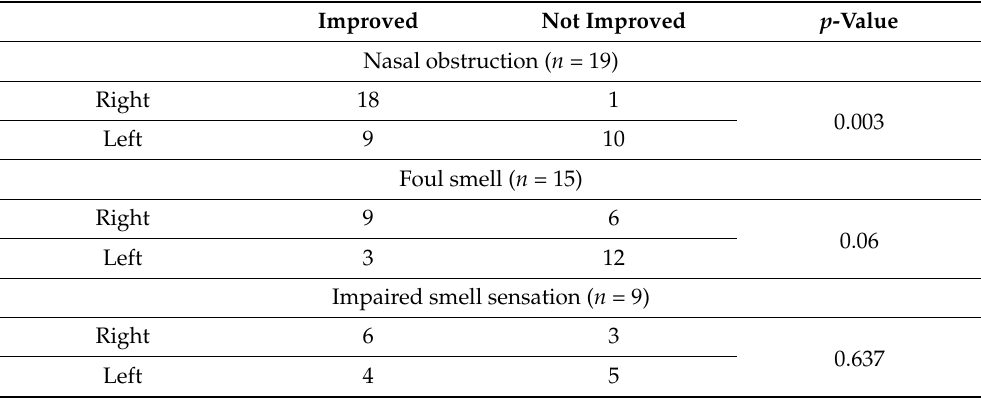
Table 3. Table showing the degree of improvement in symptoms in the case (right) and control (left) sides of the nasal cavity pre- and post-intervention, and their statistical significance using Fischer’s exact test.